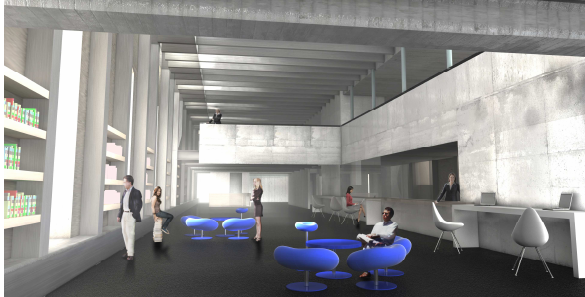
Figure 13. Photomontage of the final state of the ground